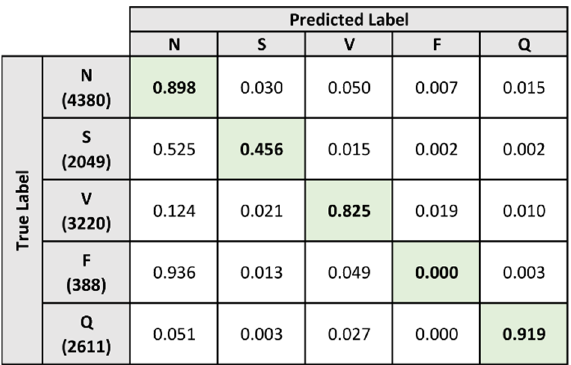
Figure 15. Normalized confusion matrix of baseline heartbeat classification on test dataset.